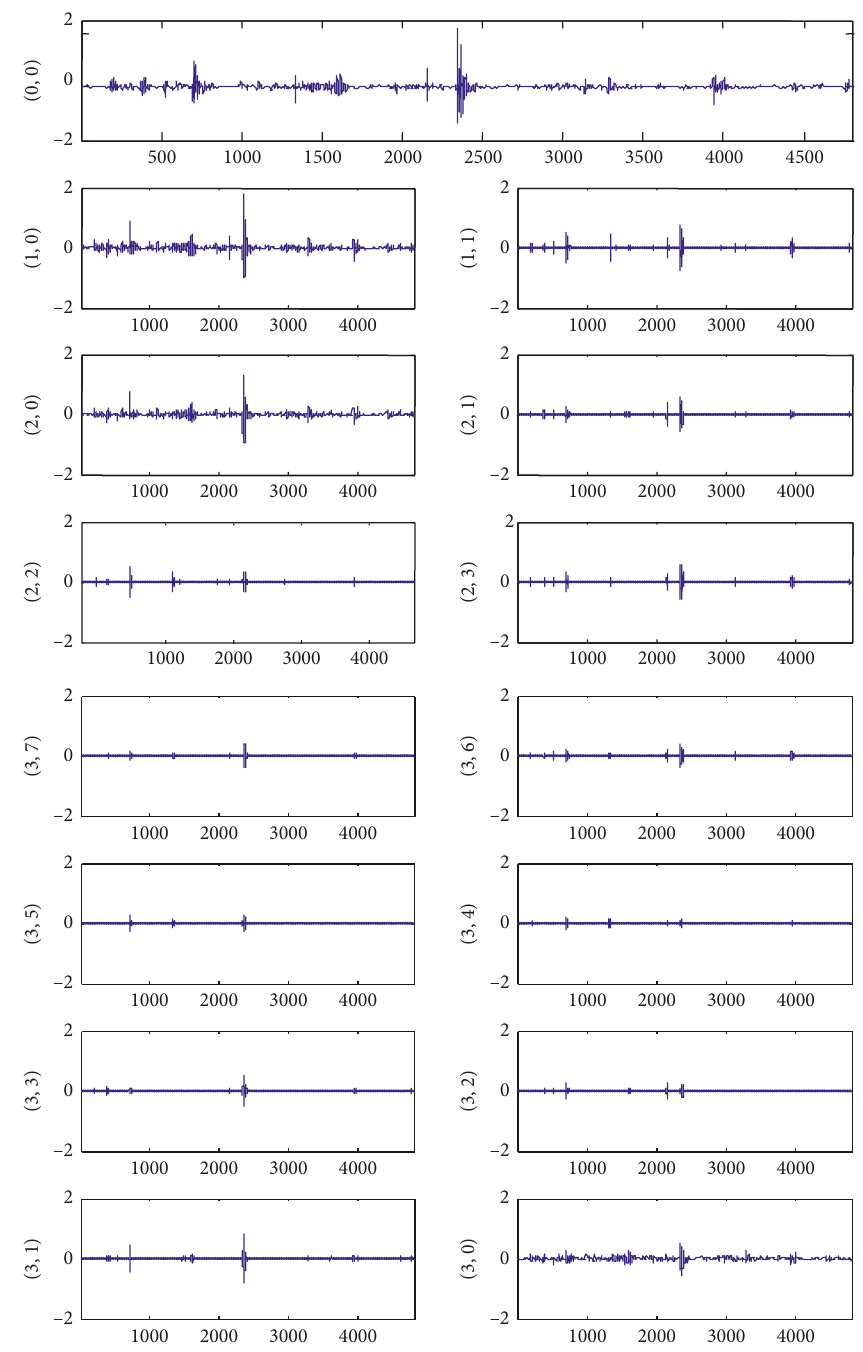
Figure 16: Reconstructed signal of each node (the abscissa is the time series and the ordinate is the